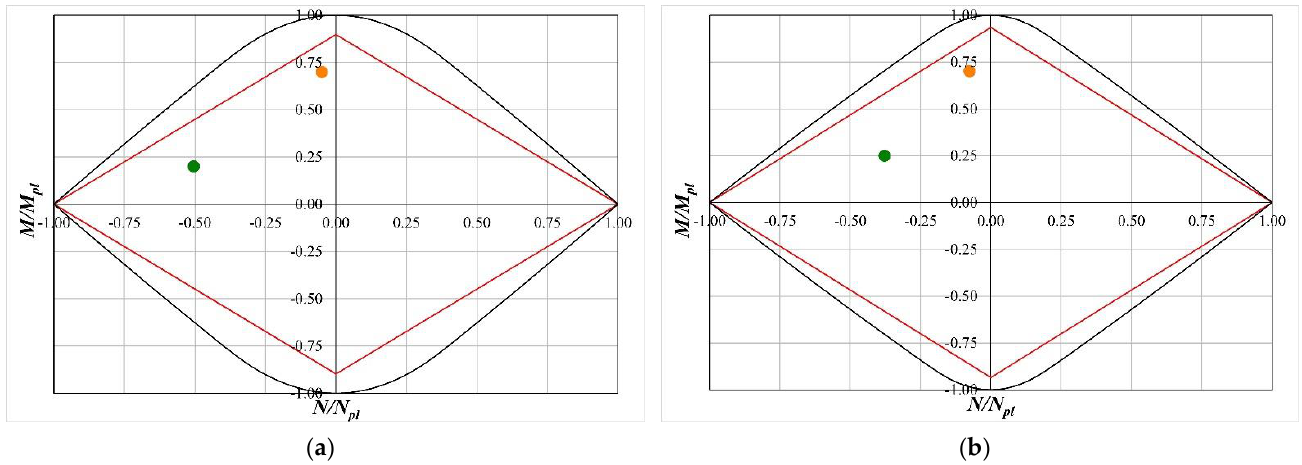
Figure 11. Dimensionless elastic (red line) and yield (black line) domains with selected design points (DP1 orange point; DP2 green point): ( a ) IPE400; ( b ) HEA300.